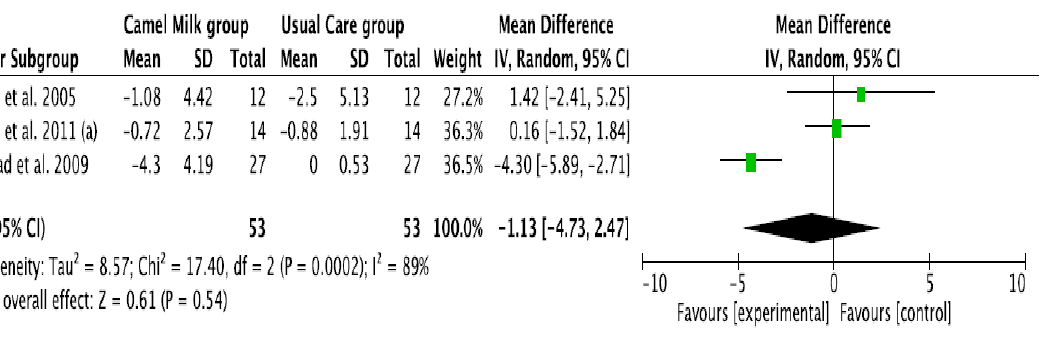
Figure 8. Forest plot for the effect of CM intake on circulating insulin antibody (IA). (a): difference